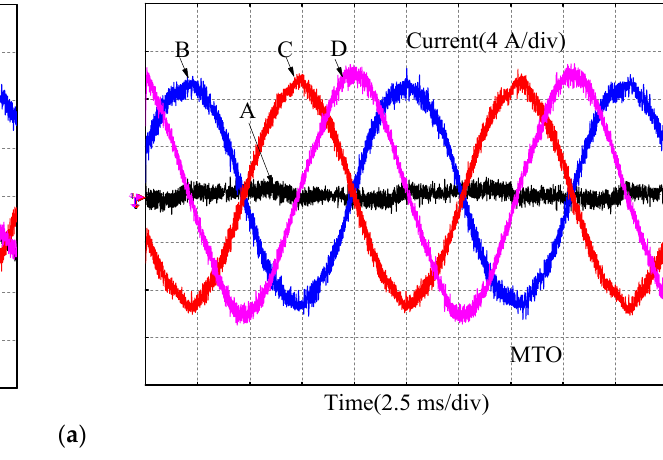
Figure 17. Motor waveform with traditional MCC and MTO. ( a ) Current waveform. ( b ) Speed waveform.